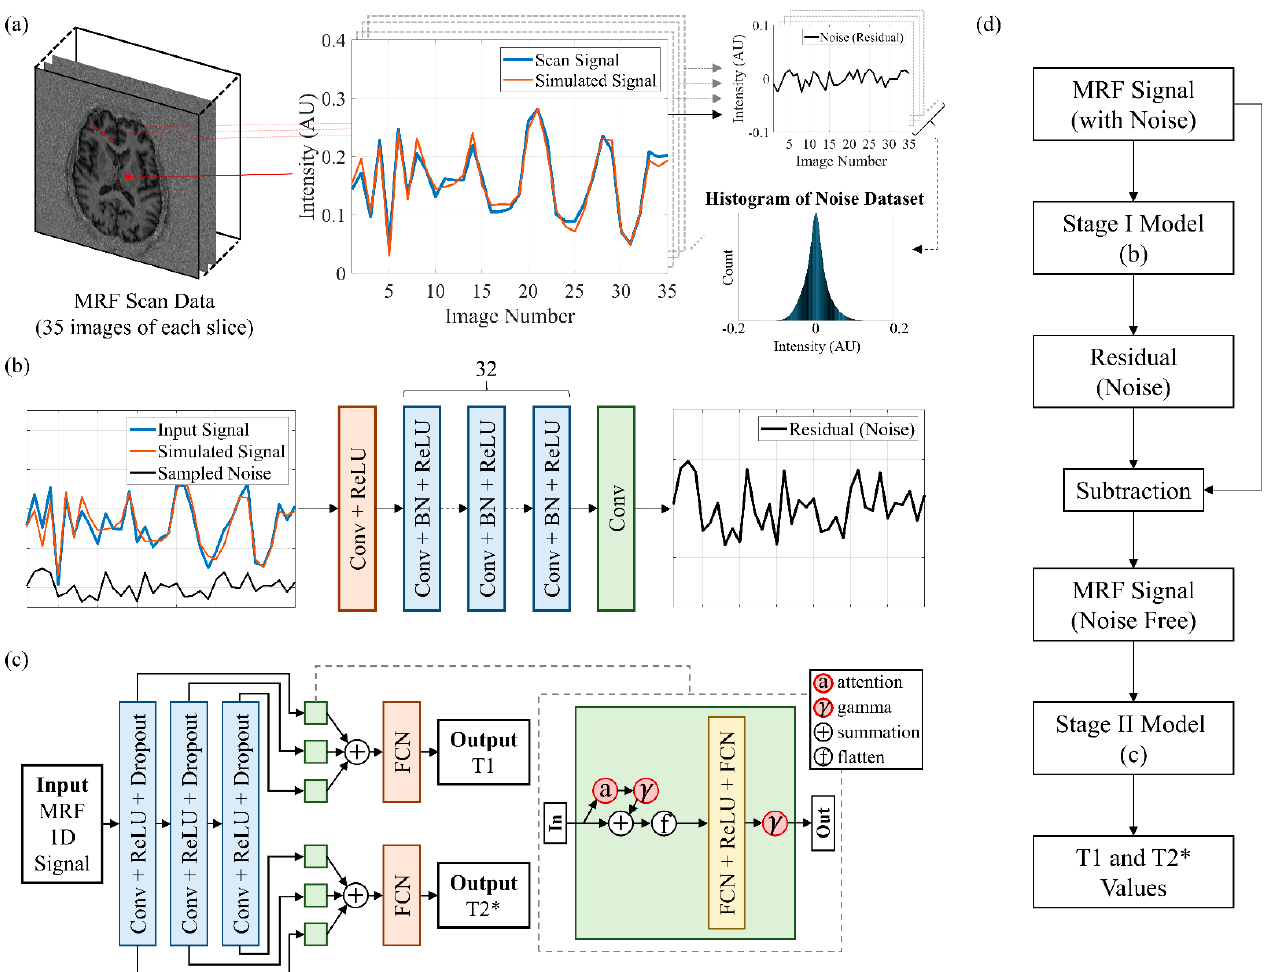
Figure 2. Schematic of the noise collection, denoising CNN, pyramid model, and flowchart of the two-stage model. ( a ) Collection of the noise dataset. AU = arbitrary unit. ( b ) Denoising CNN. ( c ) Weighted pyramid dual-path CNN with attention. ( d ) Flowchart of the successive process of the proposed model.